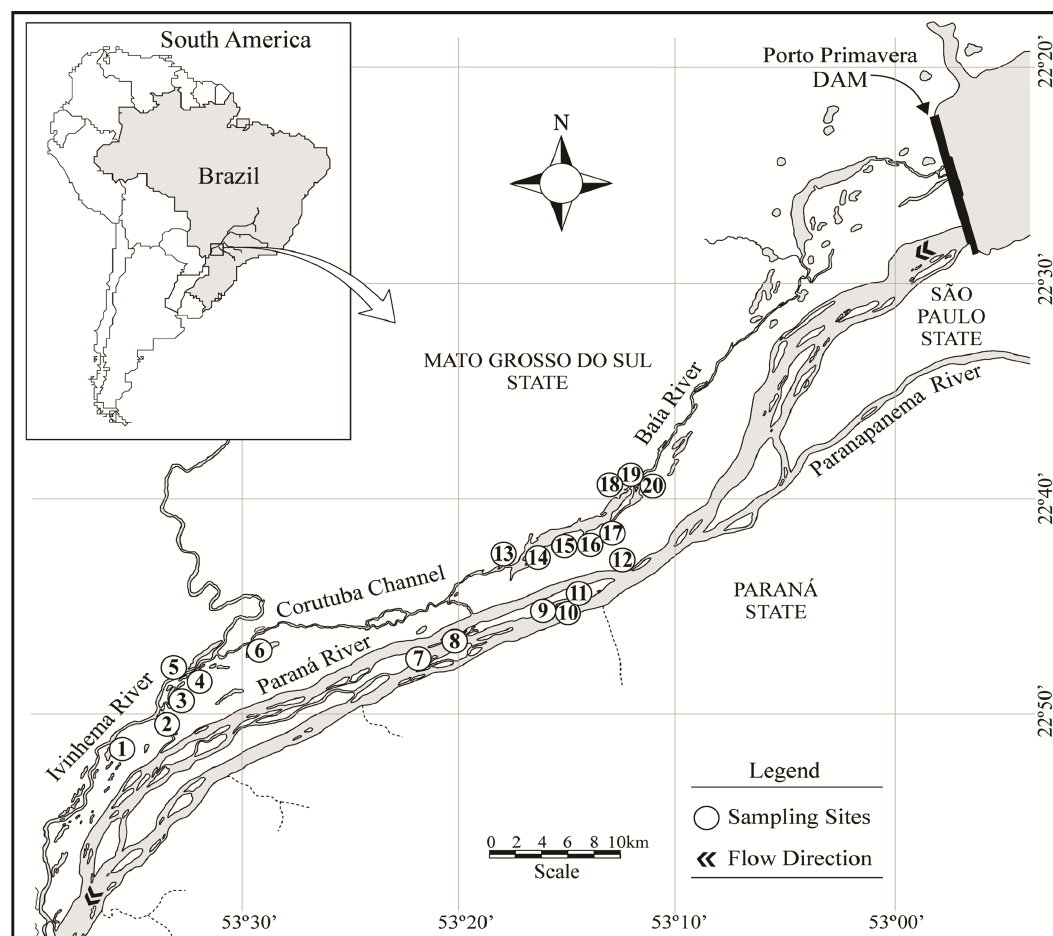
Figure 1. Map of the Upper Paraná River floodplain showing the 20 sampling sites. 1- Ventura lake; 2- Boca do Ipoitã lake; 3- Patos lake; 4- Capivara lake; 5- Joaninha lake; 6- Sumida lake; 7- Pombas lake; 8- Osmar lake; 9- Leopoldo lake; 10- Clara lake; 11- Pau Véio lake; 12- Garças lake; 13-Guaraná lake; 14- Fechada lake; 15- Pousada das Garças lake; 16- Porcos lake; 17- Aurélio lake; 18-Maria Luiza lake; 19-Gavião lake; 20-Onça